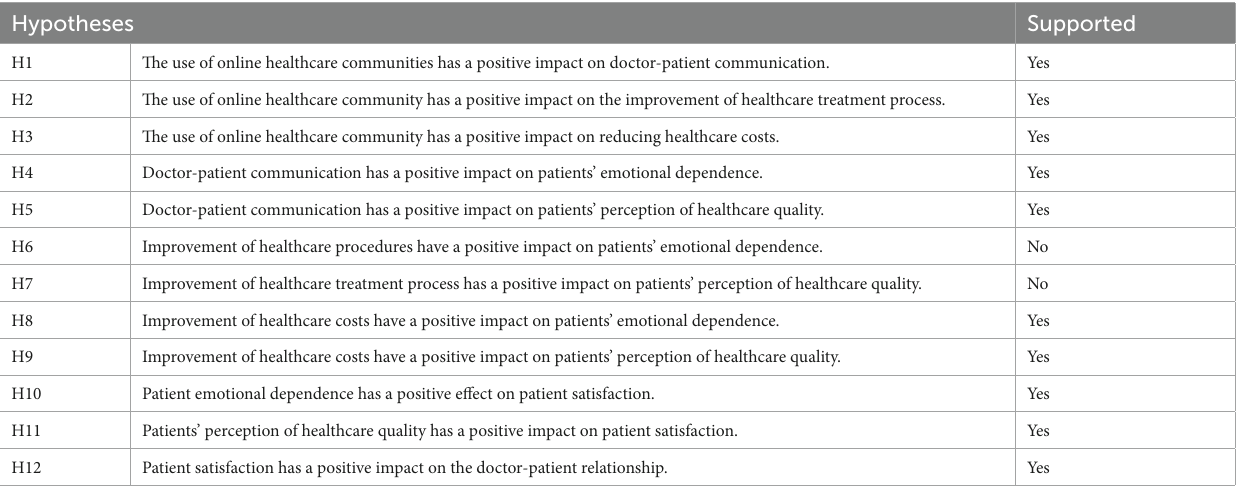
TABLE 11 Summary of hypothesis testing